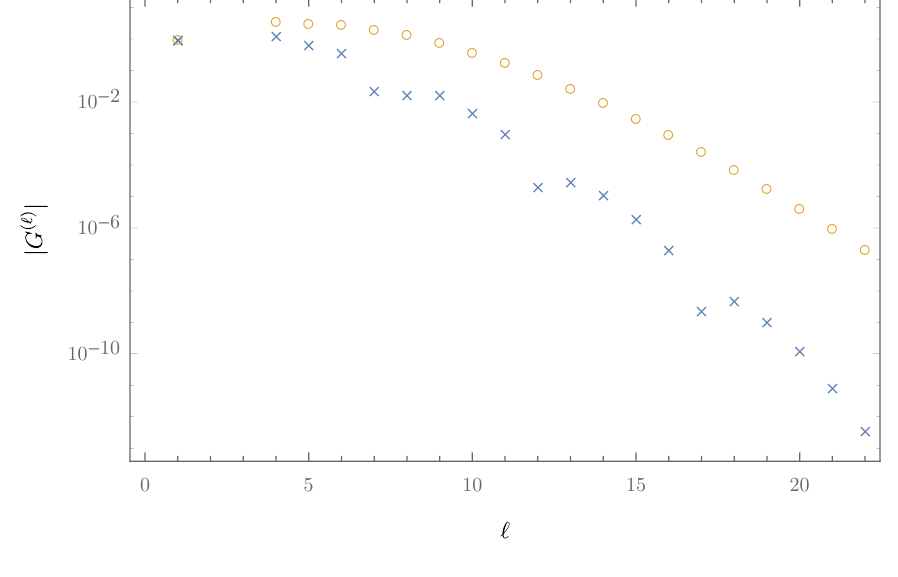
Figure 5 . Logarithmic plot of the absolute value of the coe(cid:14)cients G ( ‘ ) (4.27), for ‘ = 1 ; : : : ; 22. The j G ( ‘ ) j quickly become very small suggesting good convergence of the series. Shown is the singlet (crosses) and 27 exchange